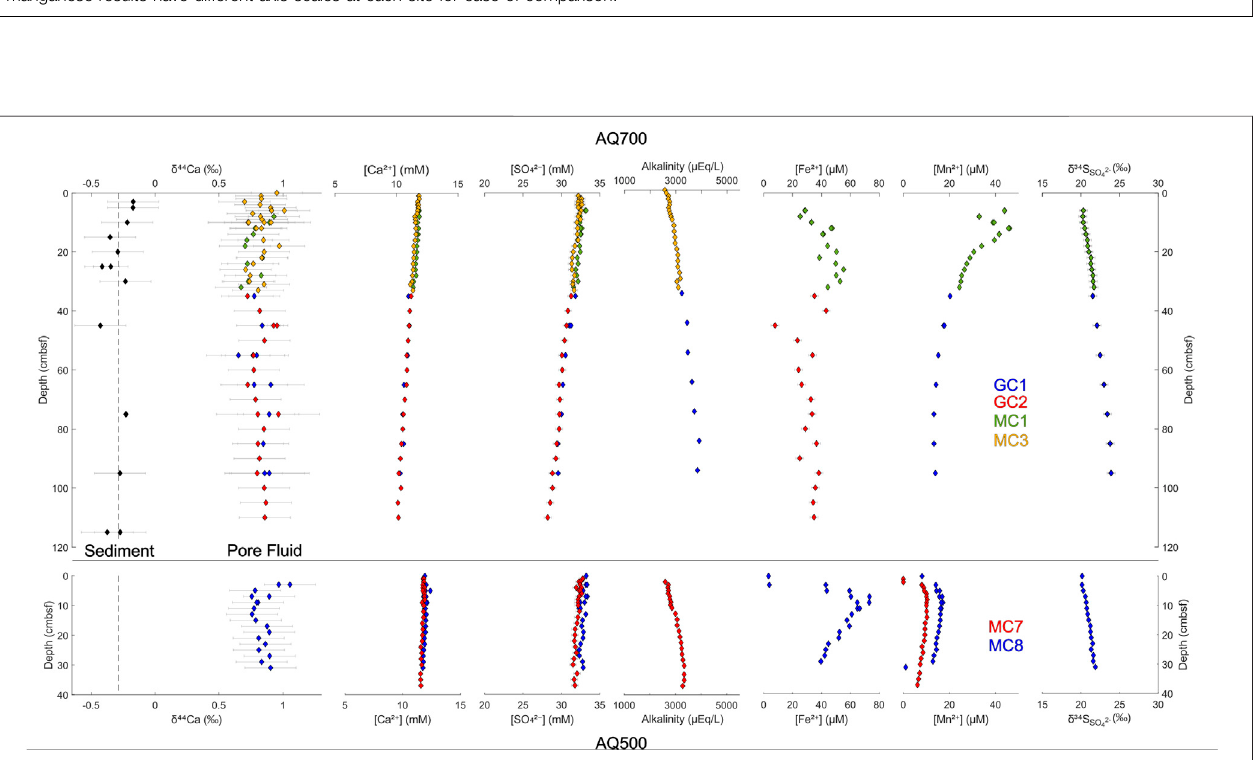
FIGURE 3 | Depth pro fi les for the Gulf of Aqaba sites AQ700 and AQ500. Individual core IDs are color-coded. Pore fl uid major ion concentrations and isotopic compositions are recorded relative to sample depth in cm below the sea fl oor.